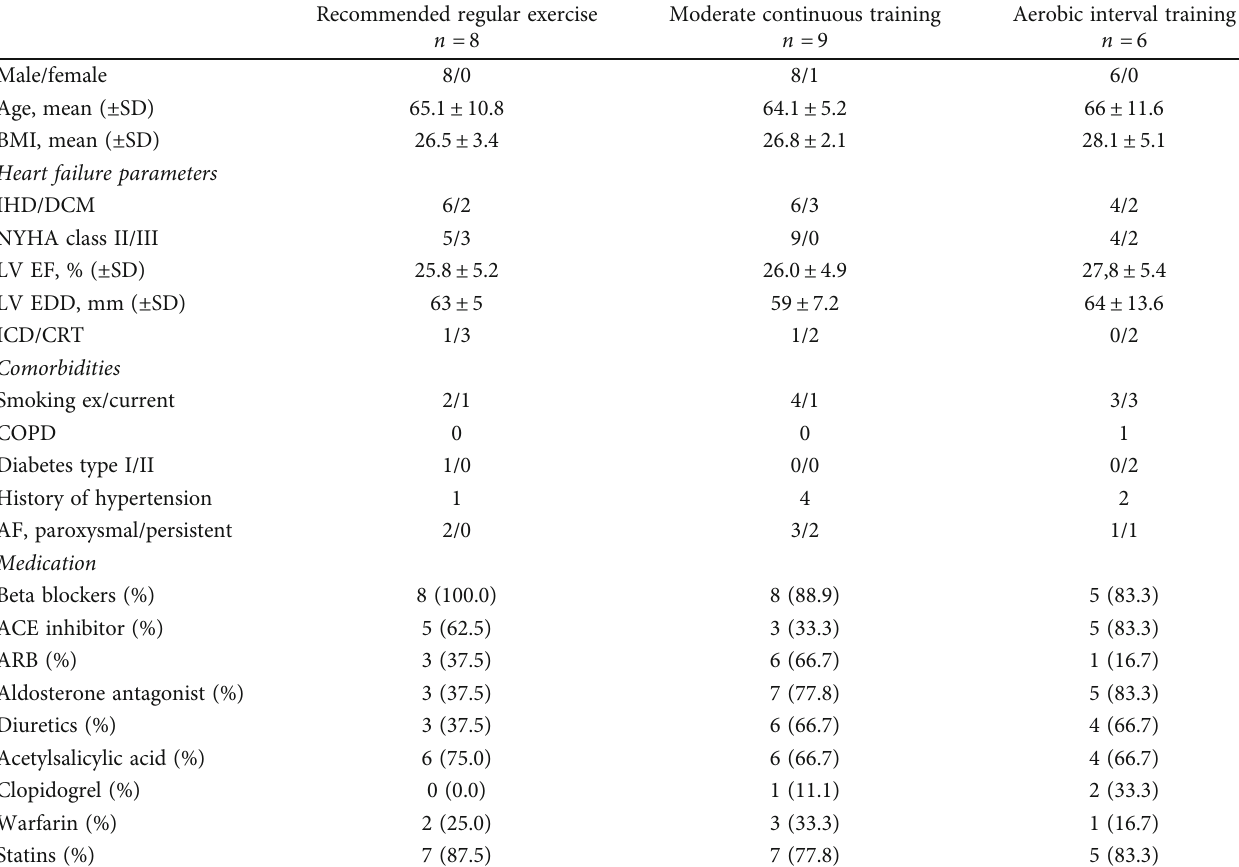
Table 1: Baseline